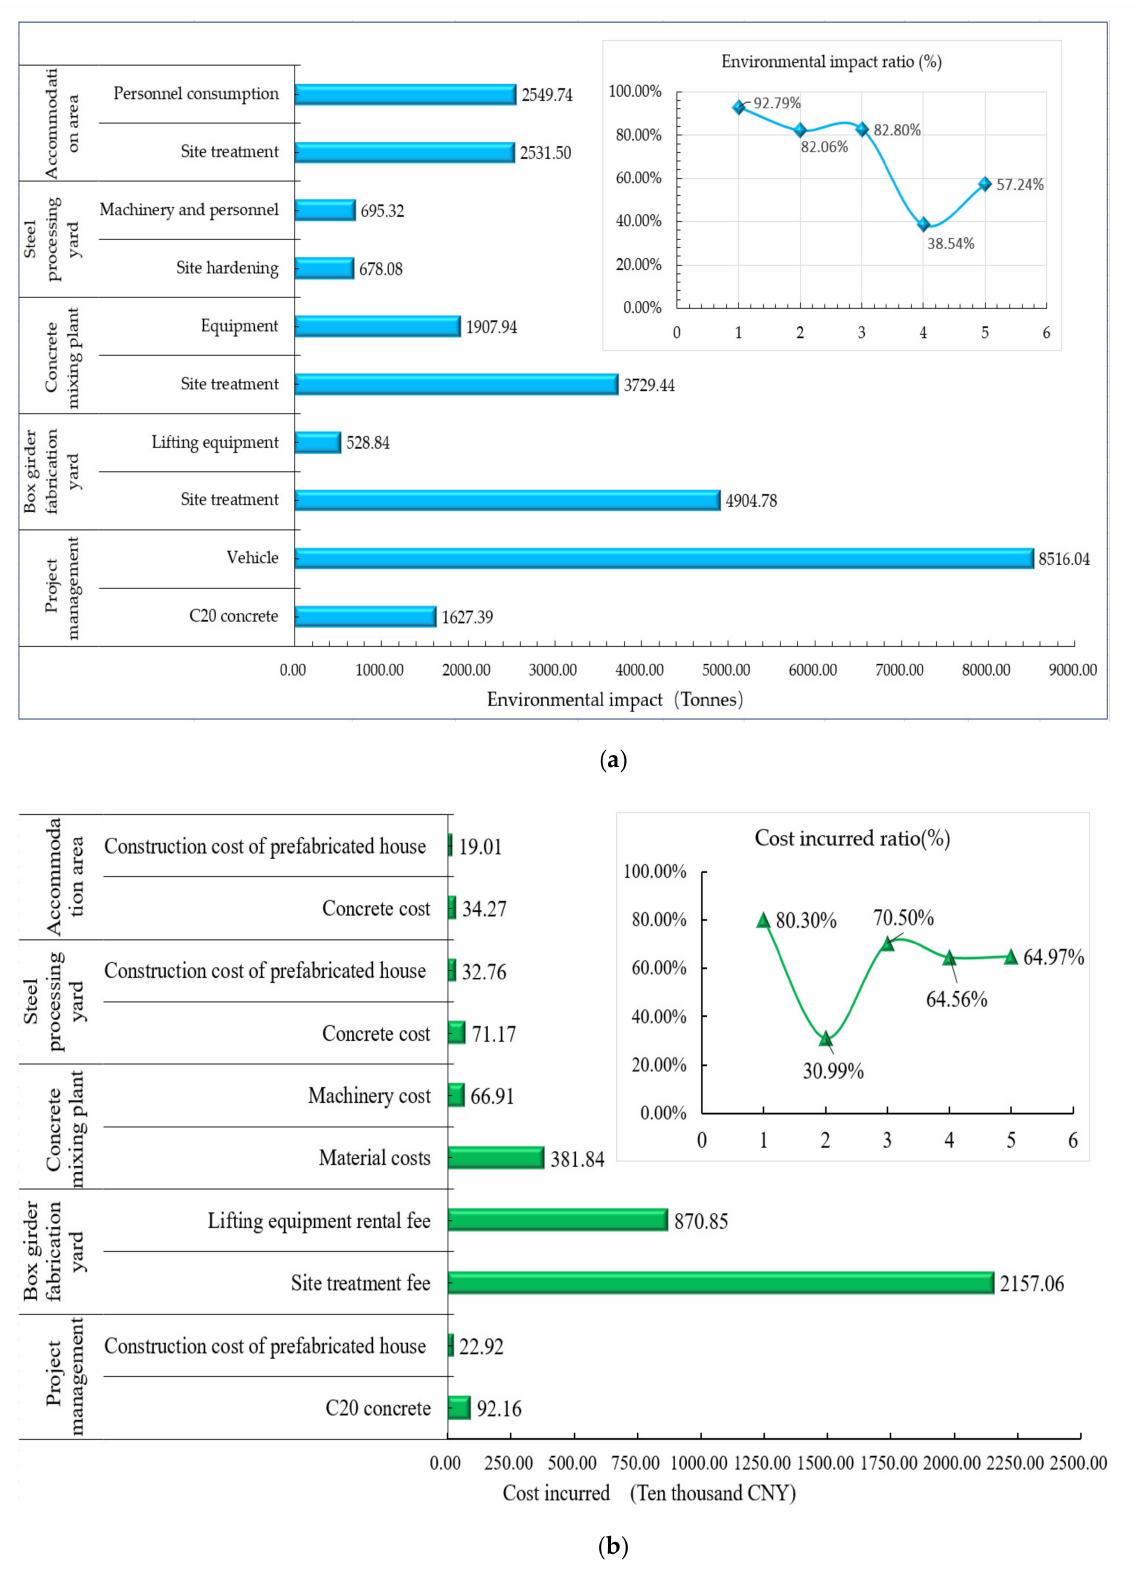
Figure 13. Analysis of auxiliary facilities: ( a ) Environmental impact; ( b ) The economic cost. Figure 14 shows the piecewise cubic interpolation performed for three types of influ- encing factors: f(x, y) = use cubic segmented surface to calculate P; x is normalized